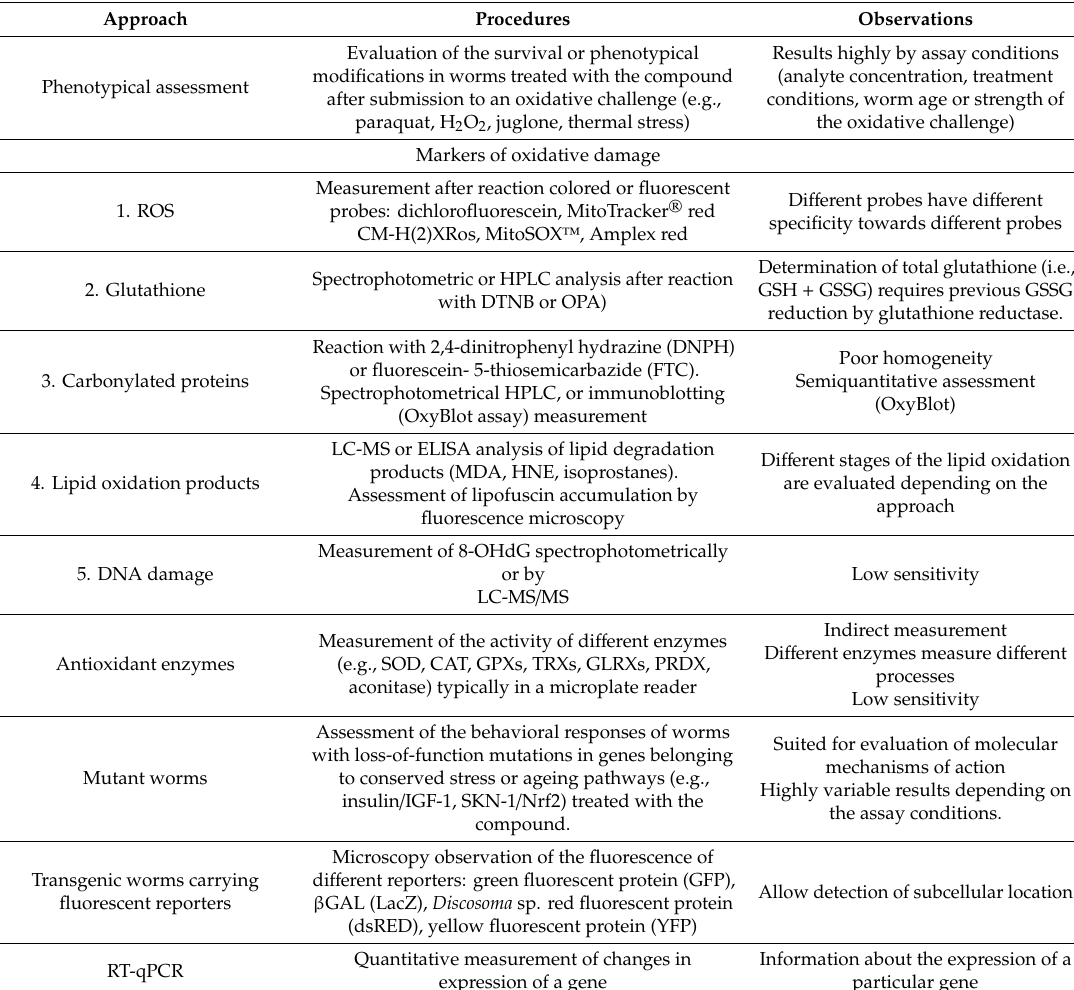
Table 3. Methodologies that can be used for the evaluation of the antioxidant potential in the C. elegans